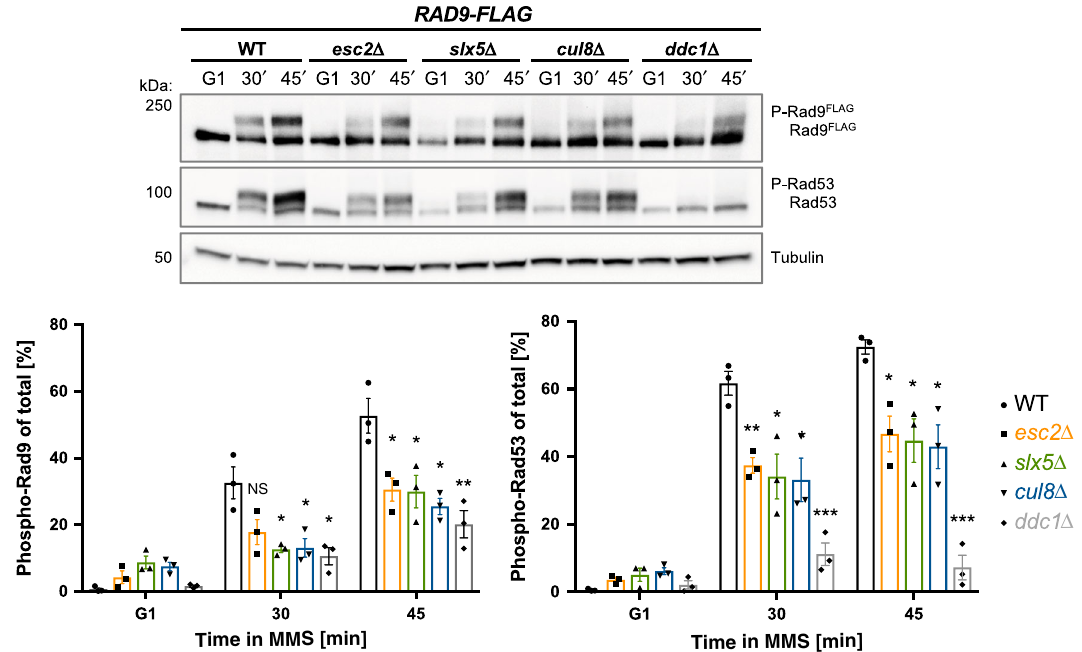
Fig. 6 Esc2, STUbL, and Cullin8 mutants have delayed DNA damage checkpoint activation. Kinetics of Rad9 and Rad53 phosphorylation in WT, esc2 Δ , slx5 Δ , and cul8 Δ cells. Rad9-FLAG-expressing cells were synchronized in G1 phase with α -factor and then released in YPD medium containing 0.033% MMS. Samples were taken at the indicated timepoints and prepared for western blot analysis using anti-Rad53 and anti-FLAG antibodies. Immunodetection of Tubulin served as a loading control. Checkpoint-de fi cient ddc1 Δ cells were used as control. Three independent experiments ( n = 3) were used for the quanti fi cation of Rad9 and Rad53 phosphorylation; the bars represent the mean values± SEM. P values were obtained by using a two- tailed unpaired Student ’ s t test with Welch ’ s correction, the asterisks indicate * P < 0.05, ** P < 0.01 and *** P < 0.001. P values for Rad9 quanti fi cation: esc2 Δ = 0.0302 (45 min); slx5 Δ = 0.0479 (30 min), 00336 (45 min); cul8 Δ = 0.0344 (30 min), 0.0206 (45 min); ddc1 Δ = 0.0259 (30 min), 0.0092 (45 min). P values for Rad53 quanti fi cation: esc2 Δ = 0.007 (30 min), 0.0264 (45 min); slx5 Δ = 0.0343 (30 min), 00392 (45 min); cul8 Δ = 0.0283 (30 min), 0.0346 (45 min); ddc1 Δ = 0.0005 (30 min), 0.0004 (45 min). NS stands for not signi fi cant. Source data are provided as a Source data fi